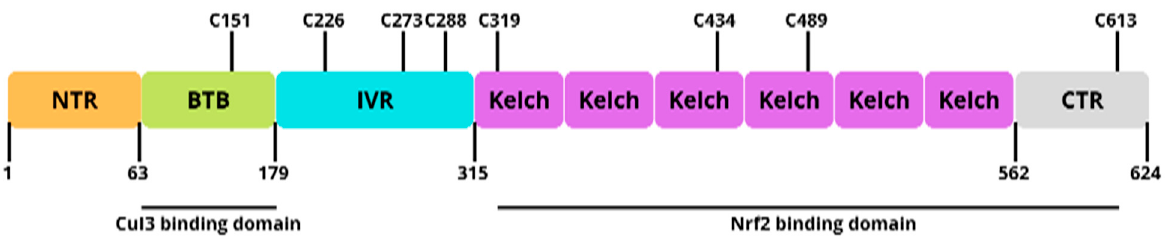
Figure 5. Domain structures and functional domains of Keap1.